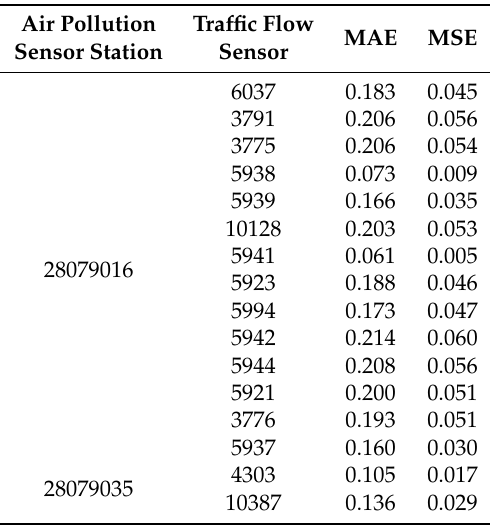
Table 3. Mean absolute error (MAE) and mean squared error (MSE) for two considered traffic flow forecasting for considered traffic flow